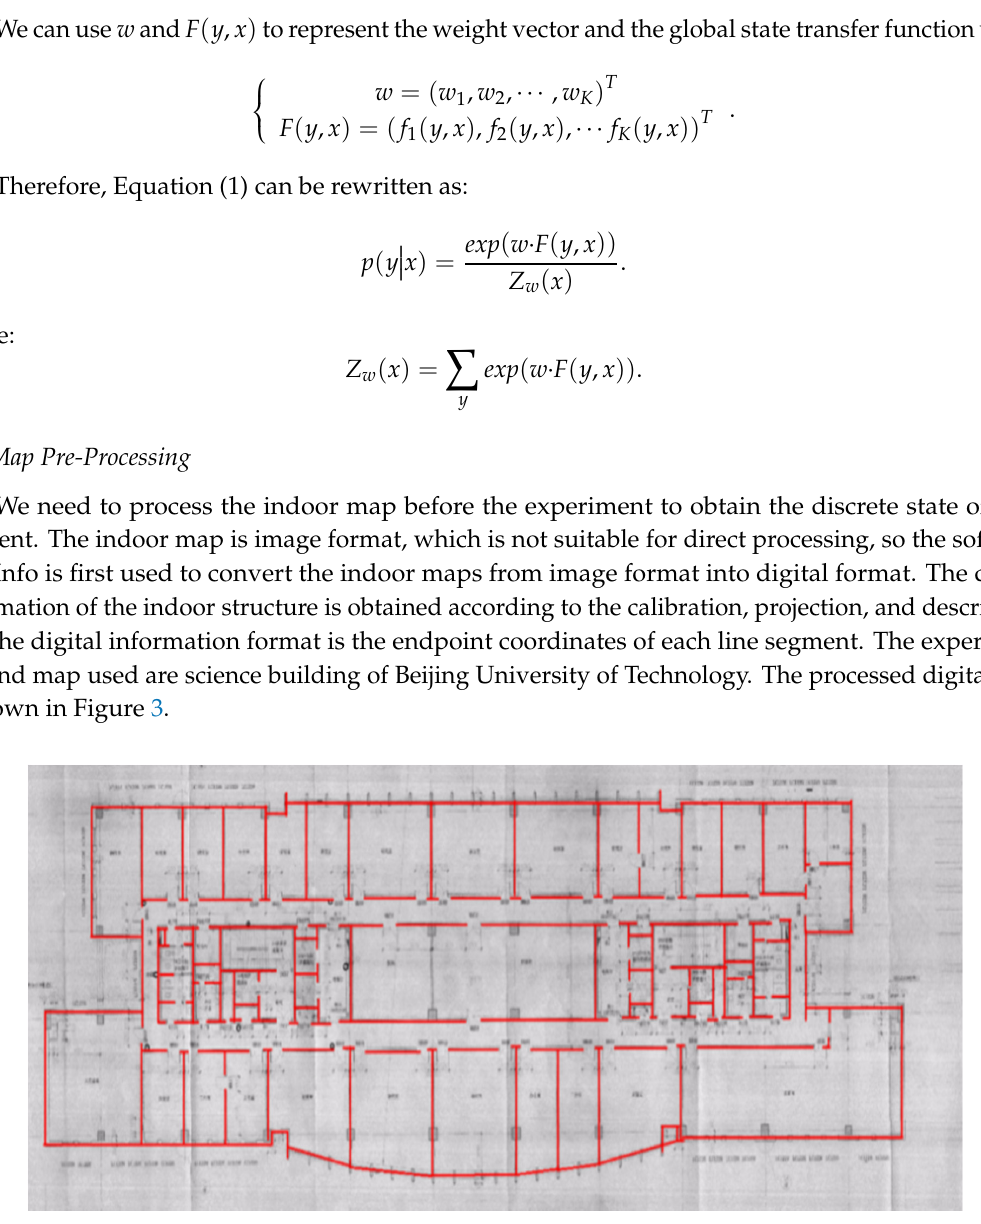
Figure 3. Digital format map.